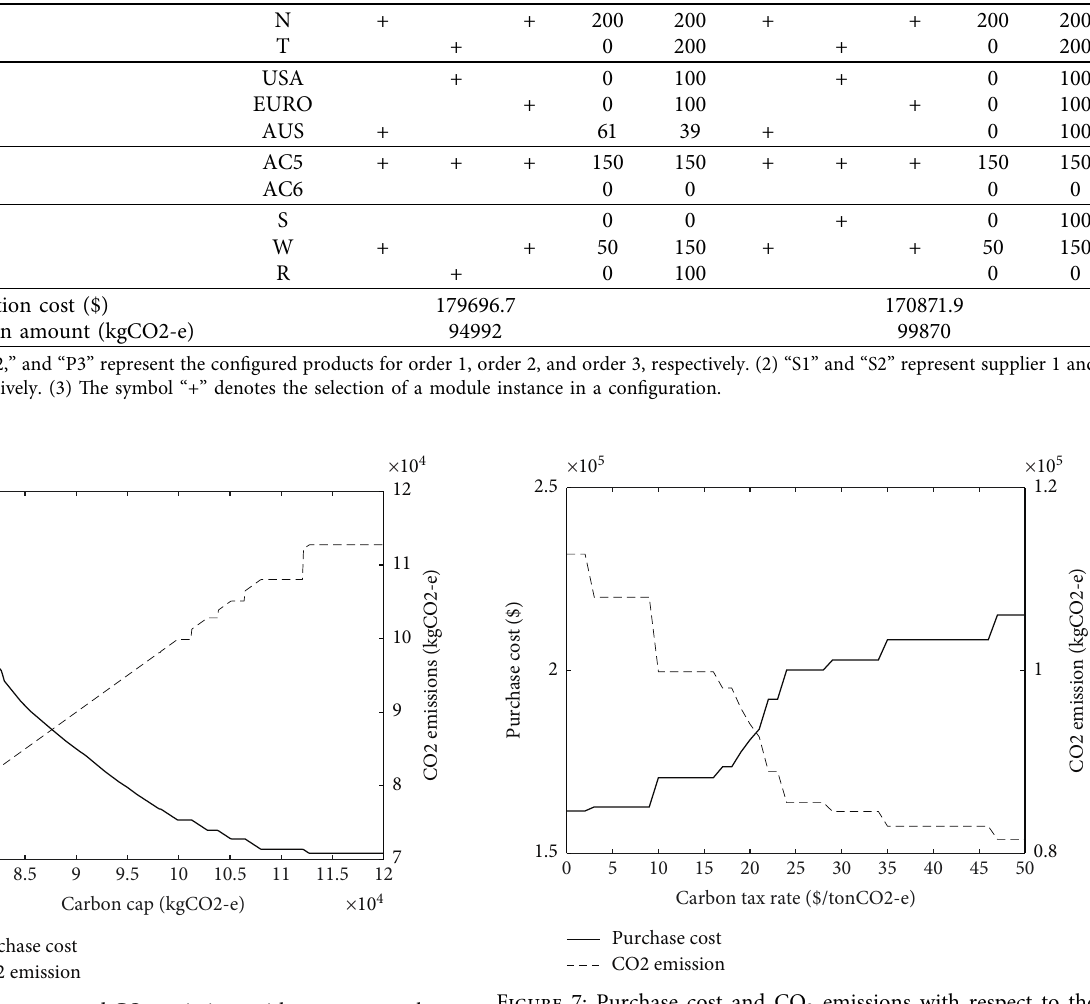
2 emissions with respect to carbon